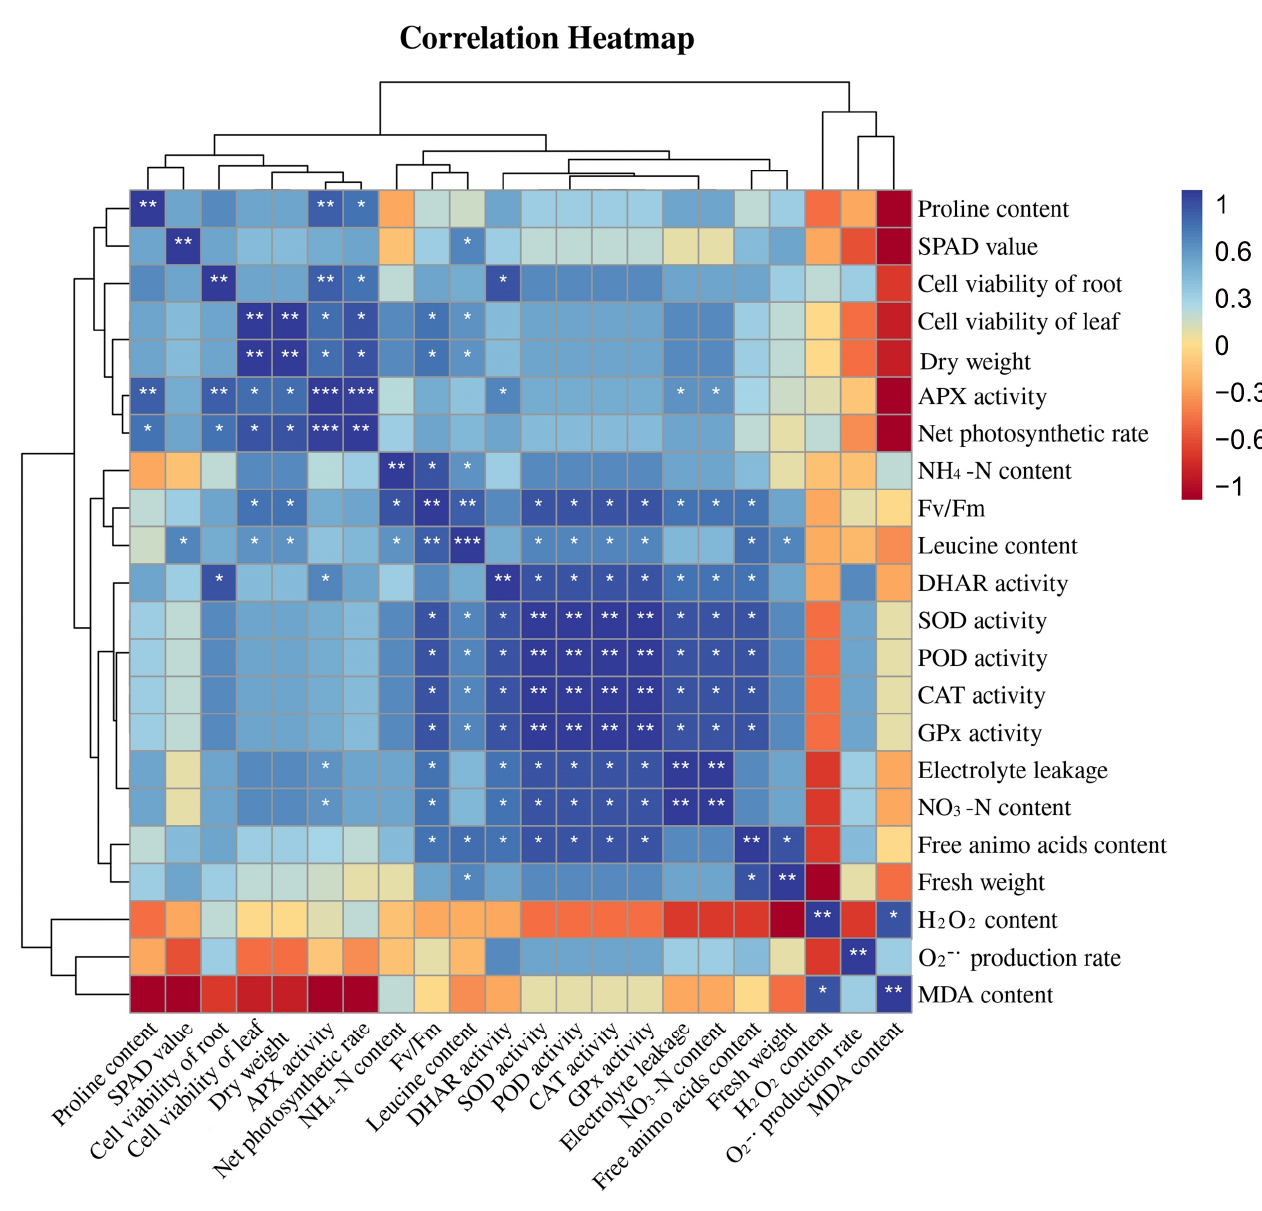
Figure 7. Correlation analysis of leucine content with the osmotic system and the antioxidant system in peach seedlings (Duncan test, * p ≤ 0.05, ** p ≤ 0.01, *** p ≤ 0.001).